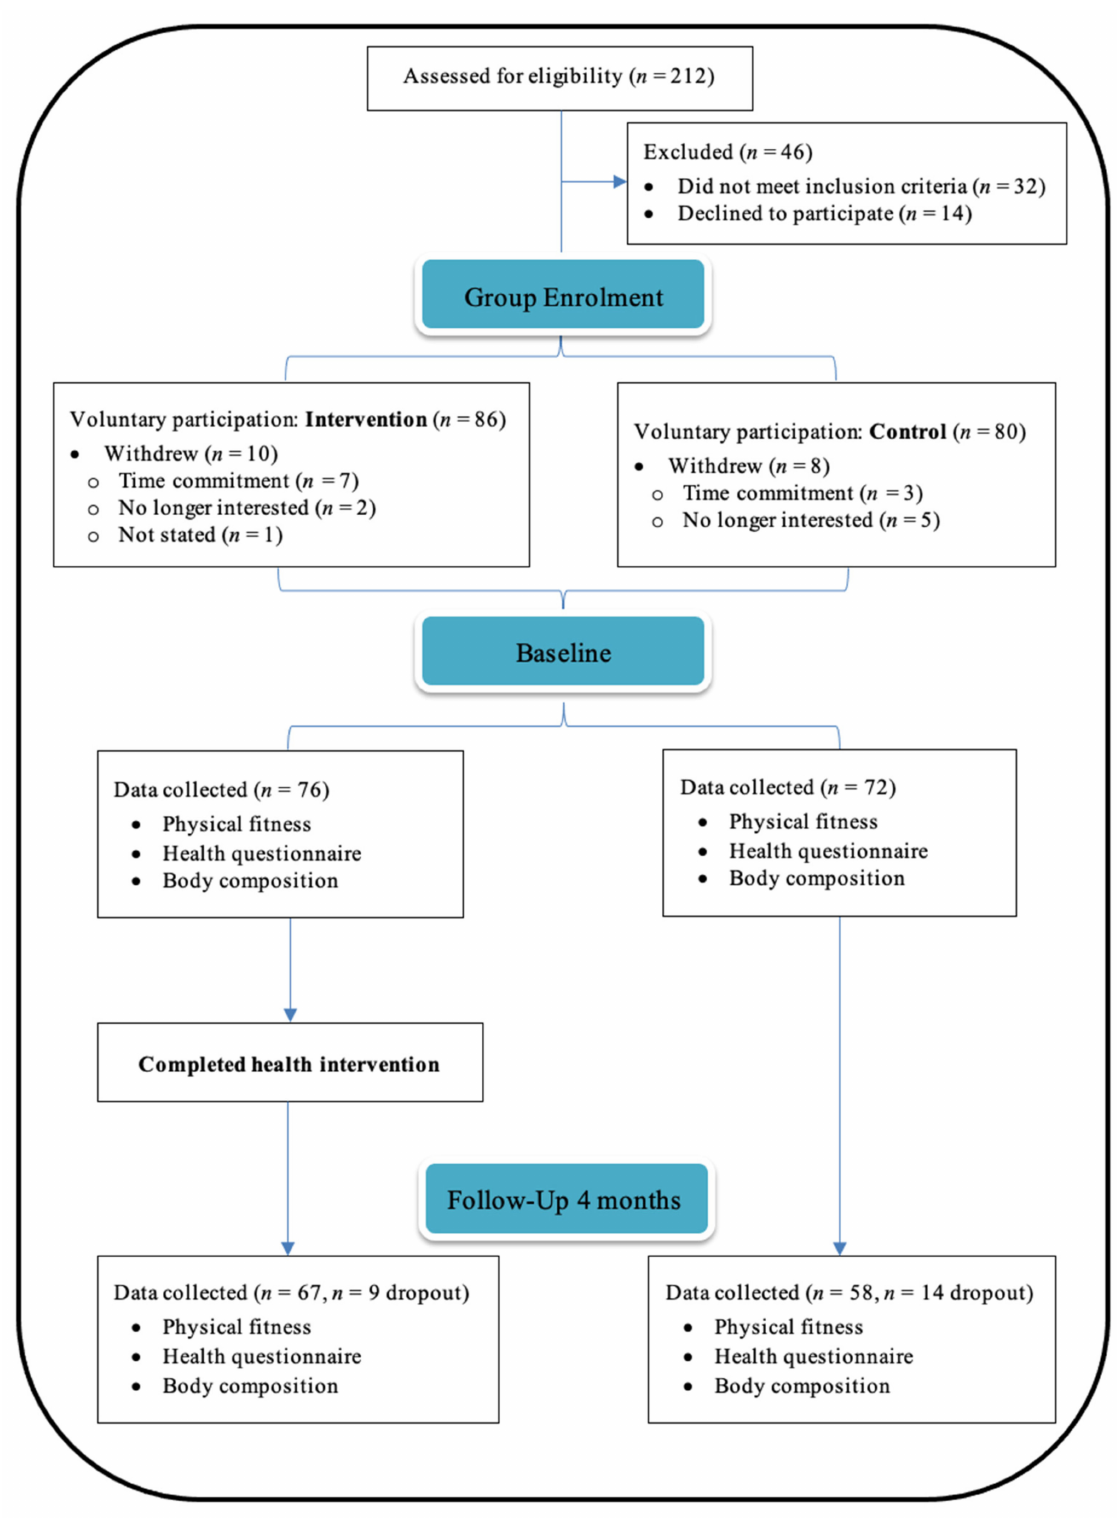
Figure 1. Flow diagram of participant recruitment and data